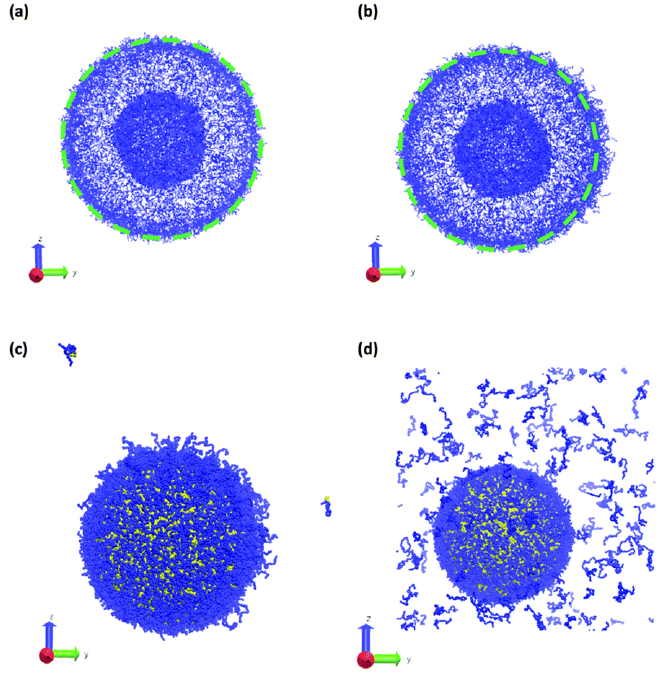
Figure 9. Vesicle morphology at t = 2.5, 104 following an instantaneous change at t = 0 of the block fraction of a localised portion on the right side (positive y -direction) of the vesicle from f A = 0.2 to ( a ) f A = 0.1, ( b ) f A = 0.4, ( c ) f A = 0.8 and ( d ) f A = 1.0. As above, blue beads show A-type monomers, and, in panels ( c , d ), yellow beads represent B-type monomers. Solvent beads are not shown. The green circle in panels ( a , b ) shows the circumference of the original vesicle as a guide to the eye. (Republished with permission of Royal Society of Chemistry, from Q.Y. Zhu, T.R. Scott, D.R. Tree, Using reactive dissipative particle dynamics to understand local shape manipulation of polymer vesicles. Soft Matter 2021 , 17 , doi:10.1039/d0sm01654c; Copyright 2021; permission conveyed through Copyright Clearance Center,